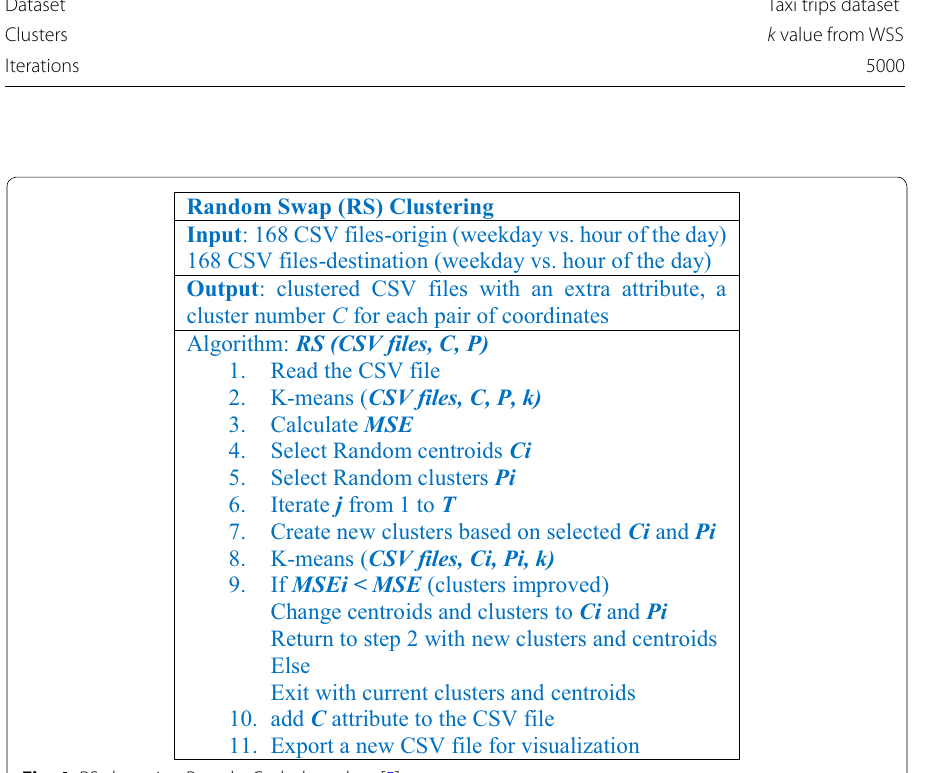
Table 3 RS customized parameters Parameter Value Dataset Taxi trips dataset